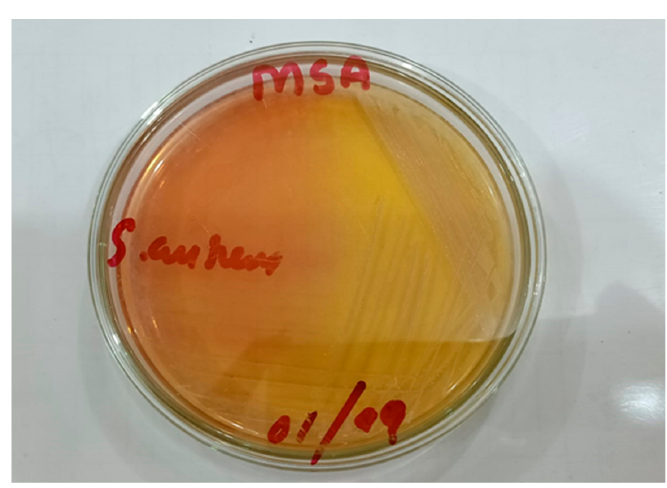
Figure 3. Pure culture of E. coli on EMB agar.